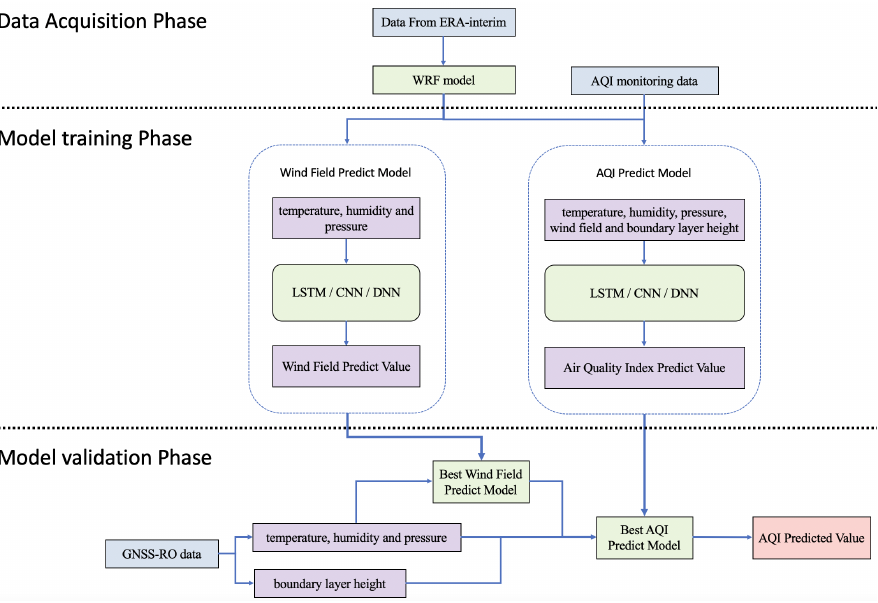
Figure 1. Overall